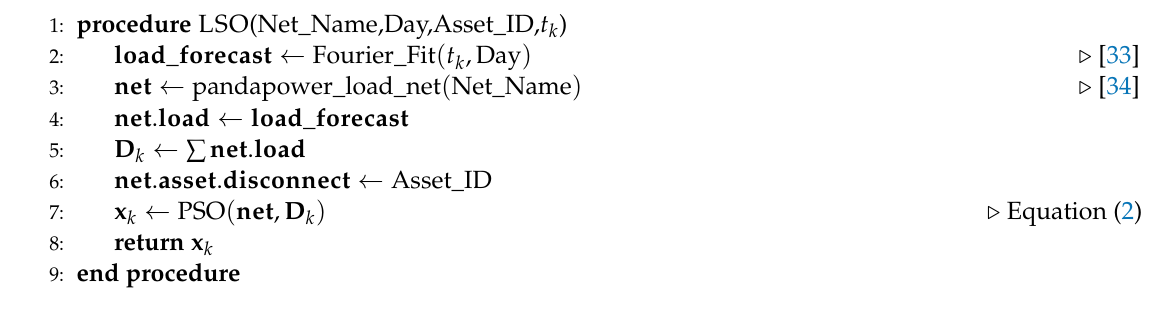
Figure 2. Load shedding algorithm. (Line 2 [33]; Line 3